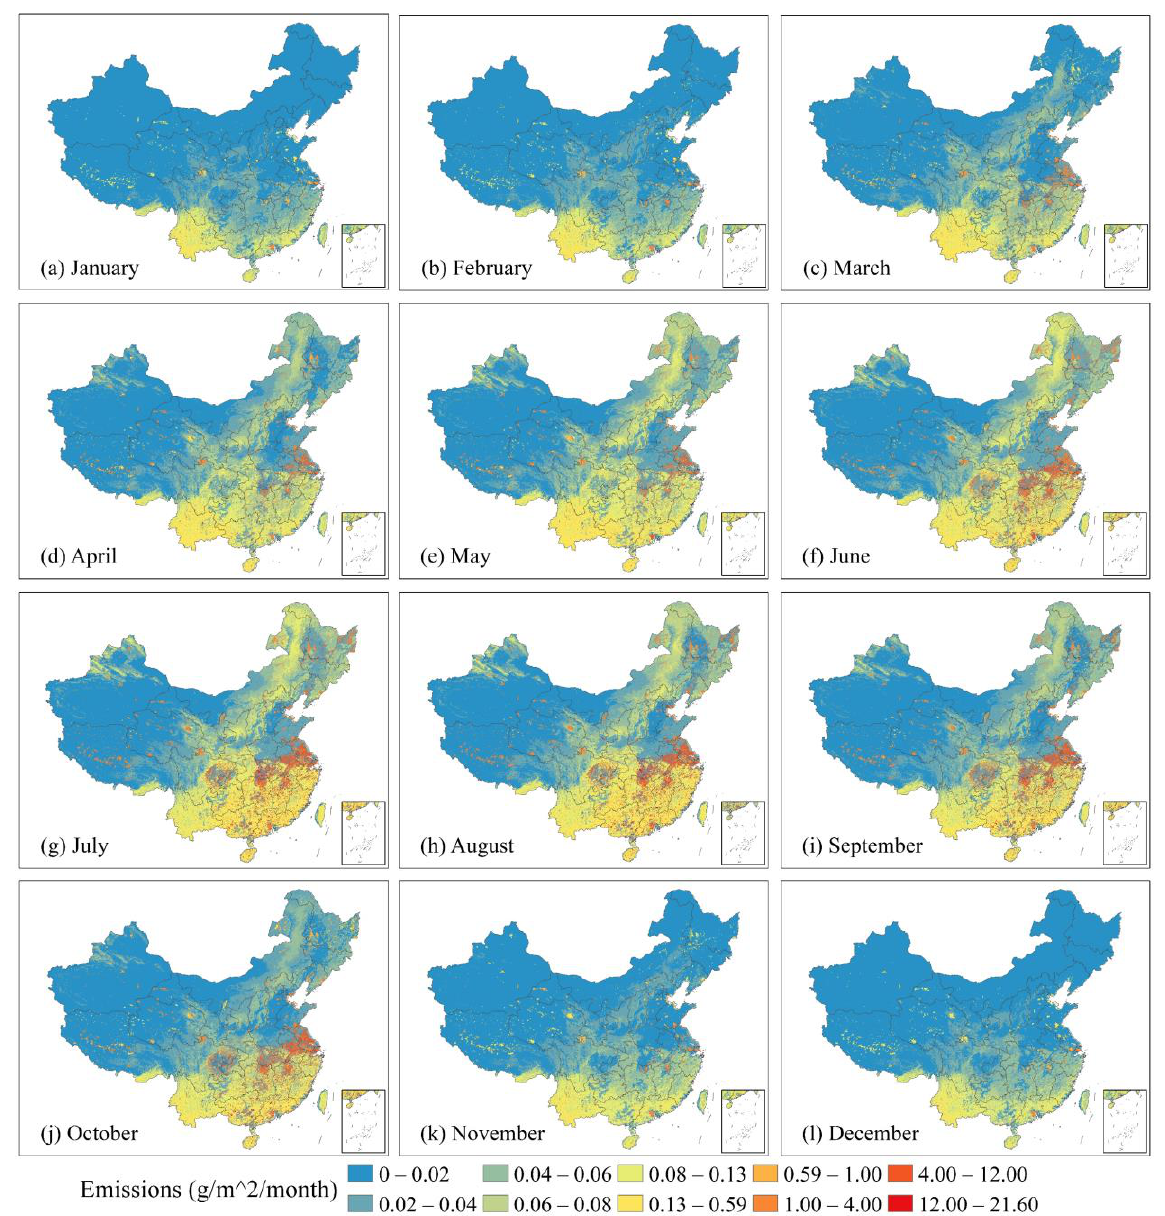
Figure 5. ( a – l ) Monthly CH 4 emission distribution map of terrestrial ecosystem in China. We plotted standard deviational ellipses of CH 4 emissions from terrestrial ecosystems in China for each season as shown in Figure 6. From spring to summer, the center of the ellipse moves to the northeast, and the azimuth of the long axis of the ellipse decreases from 84.8–71.4 ◦ . This indicates that CH 4 emissions from northern terrestrial ecosystems are increasing in summer and lead to a spatial distribution of CH 4 emissions close to the “southwest-northeast” direction. At the same time, both the long and short axes of the ellipse are increasing, indicating that the distribution range of CH 4 emissions is gradually becoming larger from spring to summer. From summer to autumn, the center of the ellipse began to move southward, and both the major axis and the minor axis of the ellipse began to decrease, indicating that the center of gravity of CH 4 emissions from terrestrial ecosystems began to move southward, and the distribution range of CH 4 emissions began to narrow. From autumn to winter, the center of the ellipse continues to move southward, and the long and short axes of the ellipse continue to decrease. This indicates that the